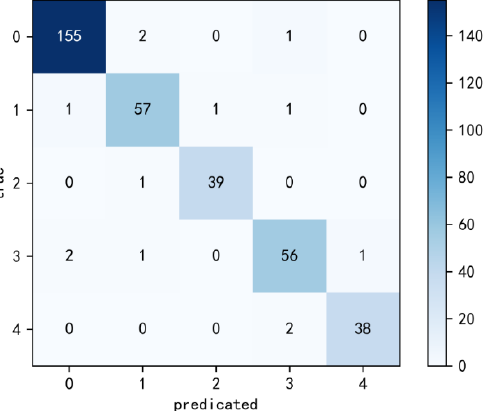
Figure 8. Classification results confusion matrix of disease damage evaluation: the vertical ordinate is the actual result, and the horizontal ordinate is the predicted result; class 0 is healthy, class 1 is mild early blight, class 2 is severe early blight, class 3 is mild late blight, and class 4 is severe late